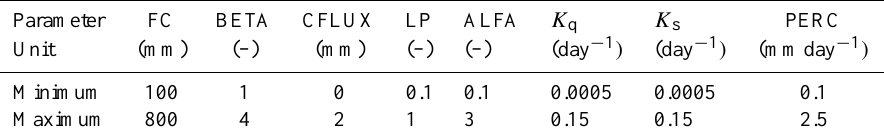
Table 1. Prior parameter